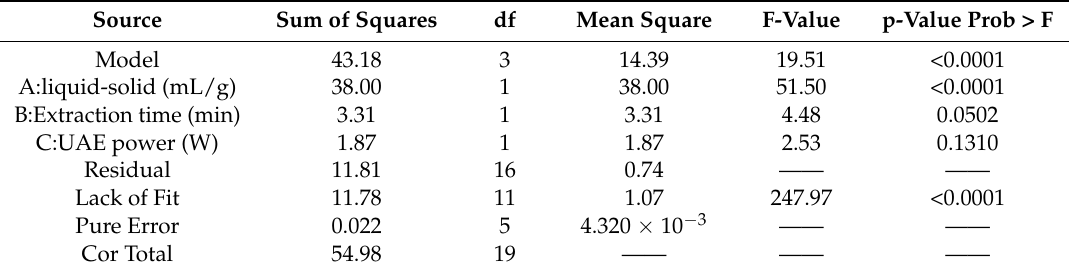
Table 1. Test of significance for regression coefficient for ultrasound-assisted extraction.